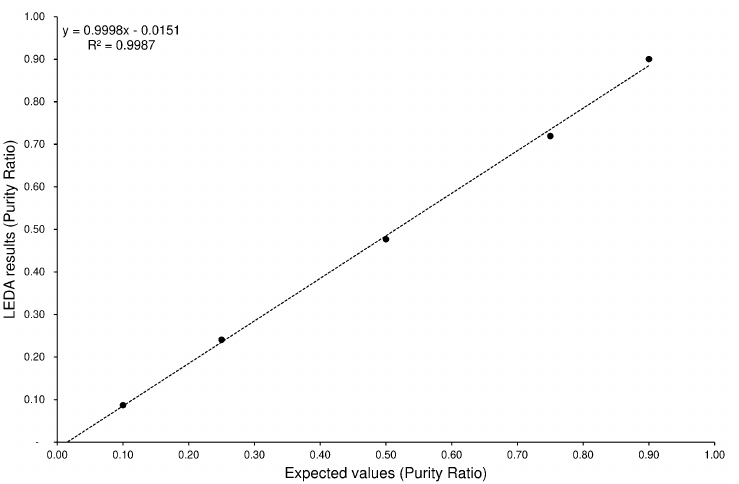
Figure 5. Validation plot obtained for the ELF96 isomer by processing the standard mixtures with LEDA 195–221 matrix.